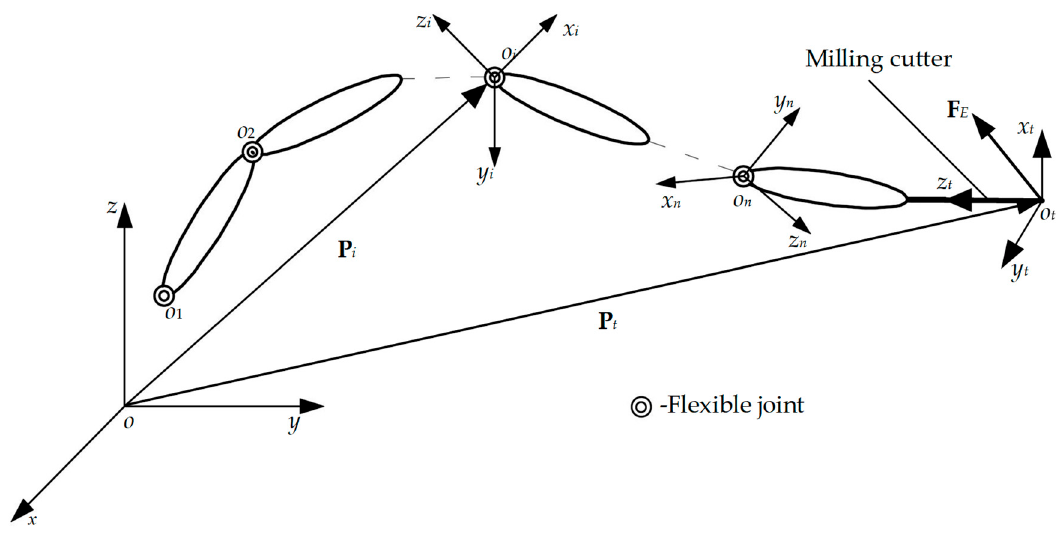
Figure 2. The kinematic scheme.